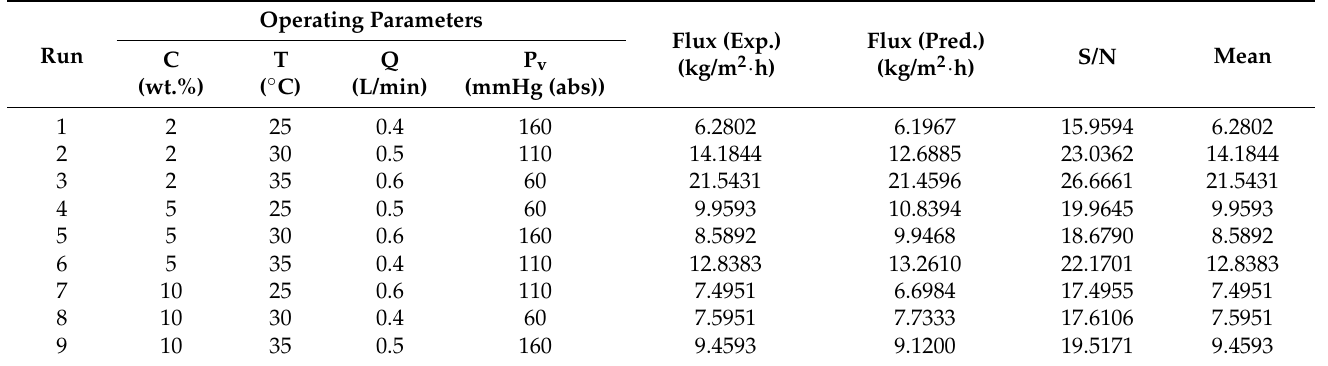
Table 4. The Taguchi L 9 (3 4 ) orthogonal array (OA), and the results of the experiments.